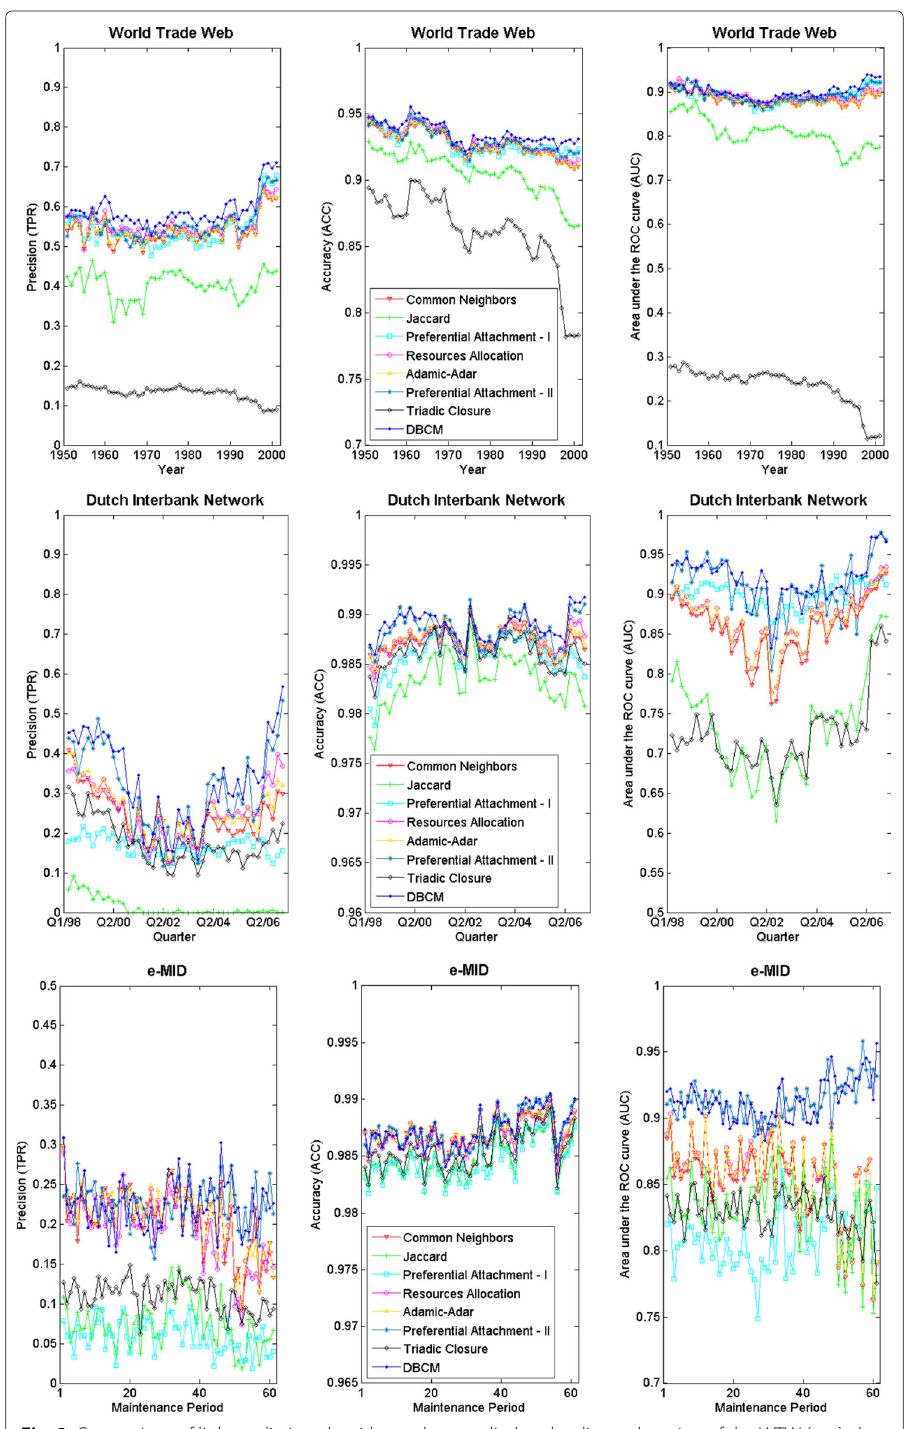
Fig. 2 Comparison of link-prediction algorithms when applied to the directed version of the WTW (top), the DIN (middle) and e-MID (bottom). Left panel: evolution of precision; middle panel: evolution of accuracy; right panel: evolution of AUC. Our entropy-based approach to link-prediction performs better than other algorithms, across the vast majority of temporal snapshots. Notice that while PA-I implements the recipe s PA (cid:10) ij = k tot i · k tot j , PA-II implements the recipe s PA (cid:10)(cid:10) ij ∝ k out i · k in